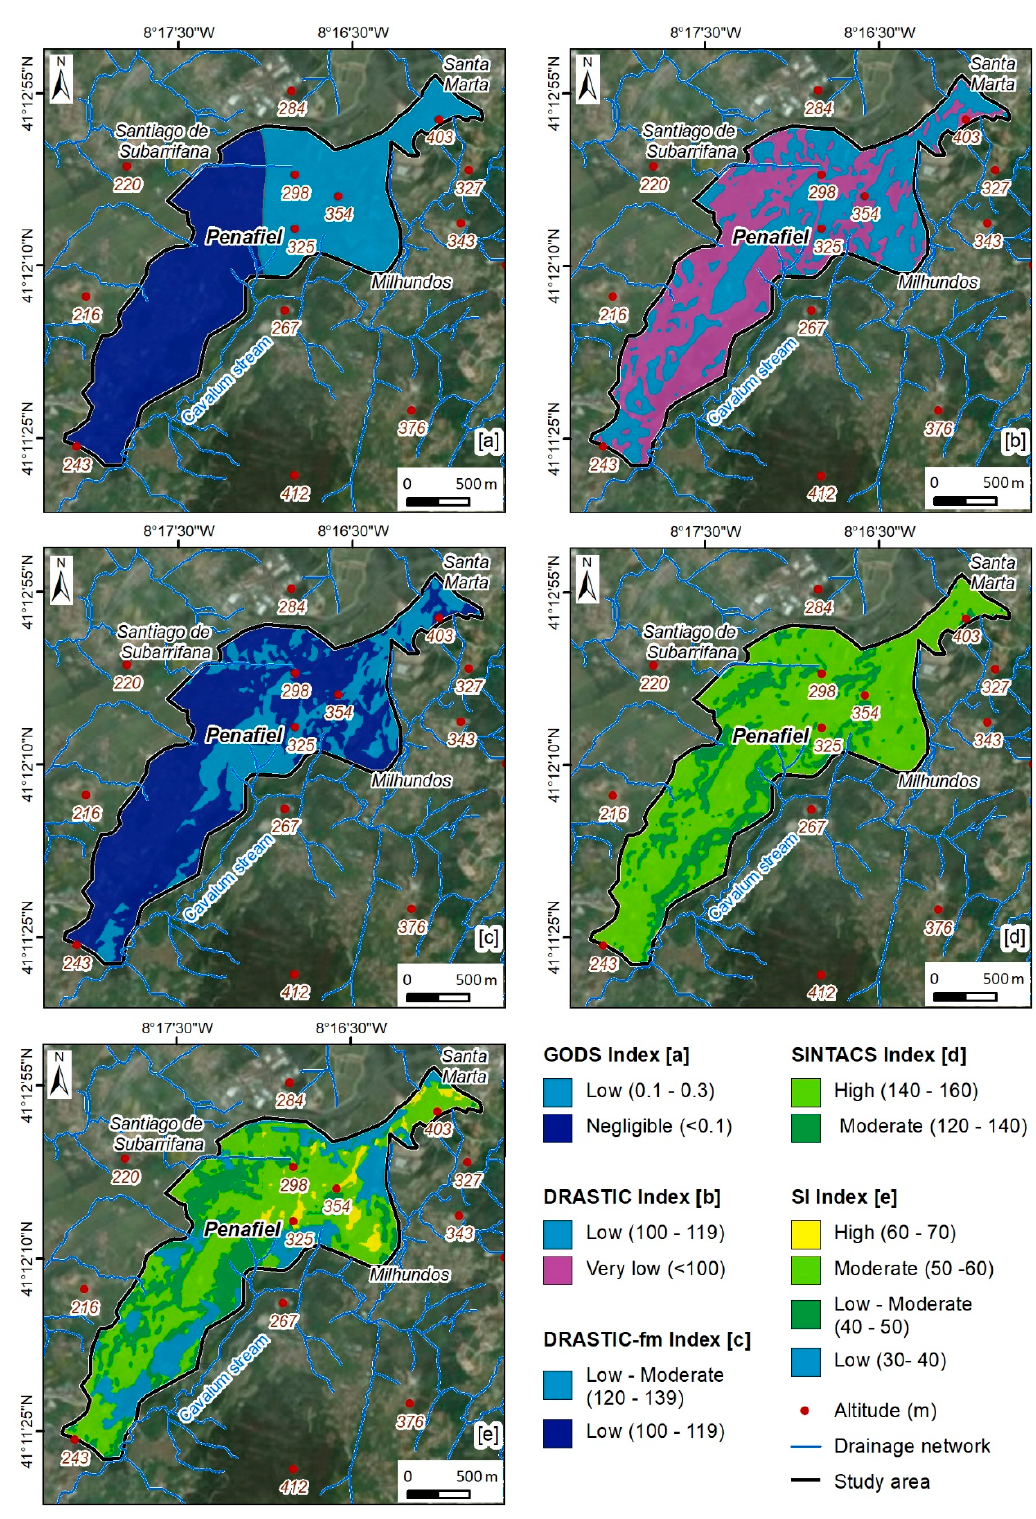
Figure 7. Urban groundwater vulnerability assessment in the Penafiel urban area (NW Portugal): ( a ) GODS; ( b ) DRASTIC; ( c ) DRASTIC-fm; and ( d ) SINTACS and ( e ) SI.